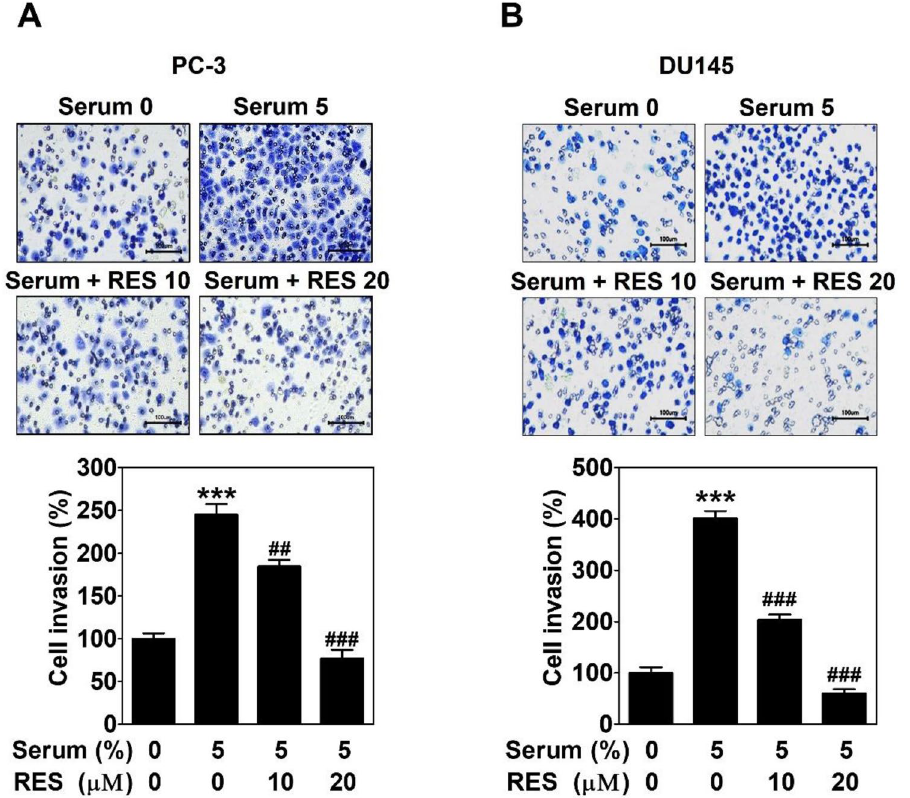
Figure 2. Resveratrol suppresses serum-induced invasion in prostate cancer cells. PC-3 ( A ) or DU145 cells ( B ) with RES seeded on a matrigel-coated up chamber of transwell and serum was filled in a down chamber. After a 24 h-incubation, the cells were fixed and stained. The images were taken with an inverted microscope at 200 × magnification. Scale bar = 100 μm. The number of invading cells was counted and expressed as a percentage of the untreated control group. Data present as the mean ± SD of three independent experiments by analysis of Student’s t- test. *** p < 0.001 versus untreated control; ## p < 0.01 and ### p < 0.001 versus serum- treated